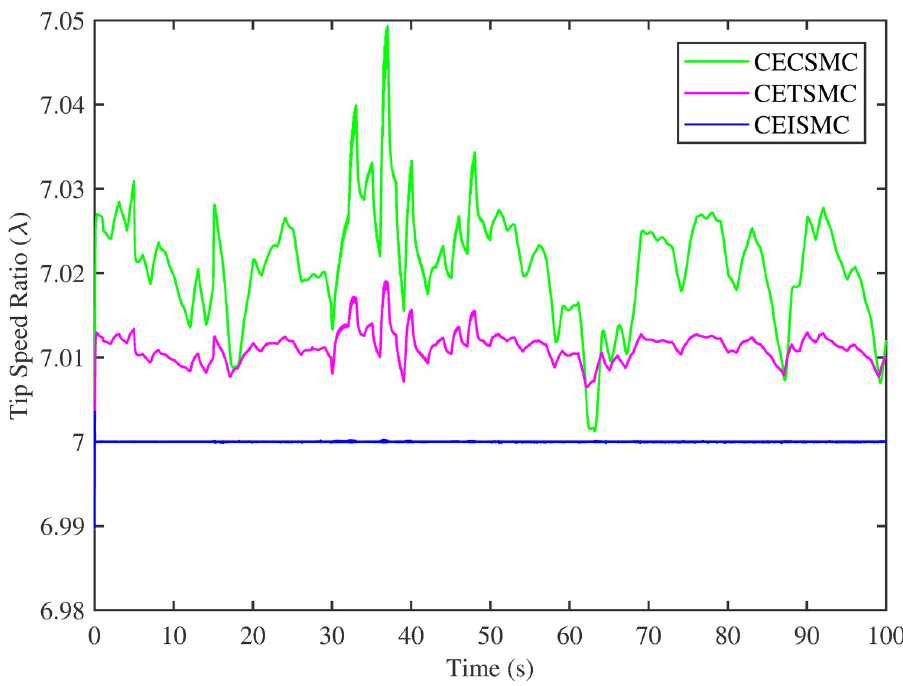
Fig 15. Tip speed ratio versus